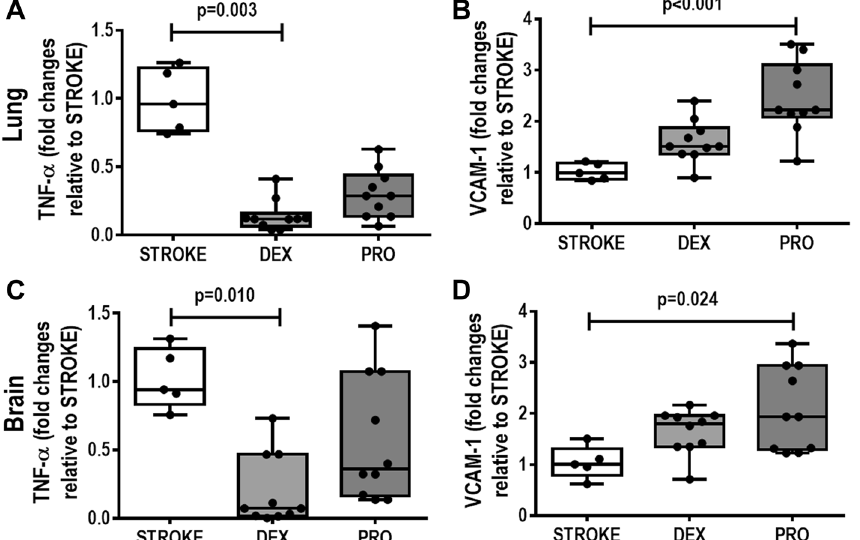
Figure 2. All animals were submitted to focal ischemic stroke. 24-h later, they were randomly assigned, by sealed envelopes, to (1) Group STROKE; (2) Group DEX; and (3) Group PRO. After 1-h of anesthetic infusion, brain and lungs were removed for molecular biology analysis. Gene expression of tumor necrosis factor (TNF)-α and vascular cell adhesion molecule 1 (VCAM-1) in lung tissue ( A , B ) and perilesional brain area ( C , D ). No difference was observed between DEX and PRO groups in relation to lung tissue TNF-α and VCAM-1 gene expressions ( p = 0.135 and p = 0.079 respectively). No difference was observed between DEX and PRO groups in relation to perilesional brain area TNF-α and VCAM-1 gene expressions ( p = 0.638 and p = 0.999 respectively). Box plots represent the median and interquartile range of 5 animals in STROKE group and 10 animals in DEX and PRO groups. Comparisons were done by Kruskal–Wallis test followed by Dunn’s multiple comparisons test ( p <